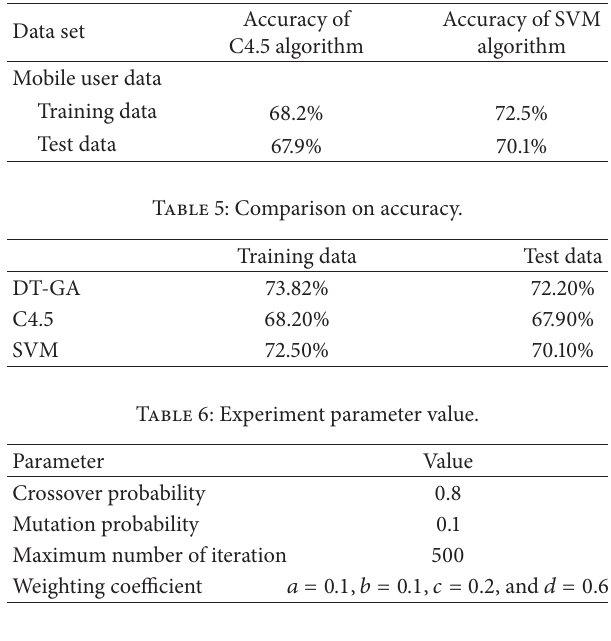
Table 7: Accuracy on Iris and Breast-cancer